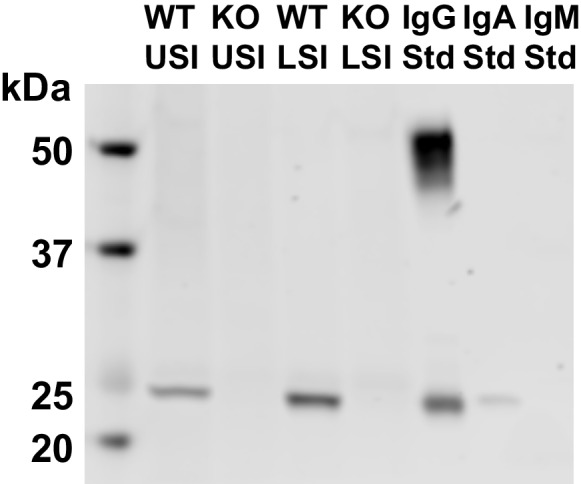
Western blots of 30 µm-filtered samples from the small intestine (SI) of wild-type (WT) and Rag1 knockout (Rag1KO) mice.WT USI = WT upper SI; KO USI = KO lower SI; WT LSI = WT lower SI; KO USI = KO upper SI. For the detection of IgG, 1:10,000 dilutions of Li-Cor IRDye 800 CW Goat Anti-Mouse IgG was used. Because the Anti-IgG antibody appears to be binding to just the light chains (around 25 kDa), we suspect that it is mostly binding to IgA. Li-Cor’s published validation (https://www.licor.com/bio/products/reagents/secondary_antibodies/irdye_800cw.html) found that the antibody binds to the heavy and light chains of IgG and just the light chains of IgA. Because we see binding of the antibody to both the heavy and light chains in the IgG standard, but only binding to a light chain in the SI samples and the IgA control, this suggests that we are detecting the light chains of IgA in the SI samples.